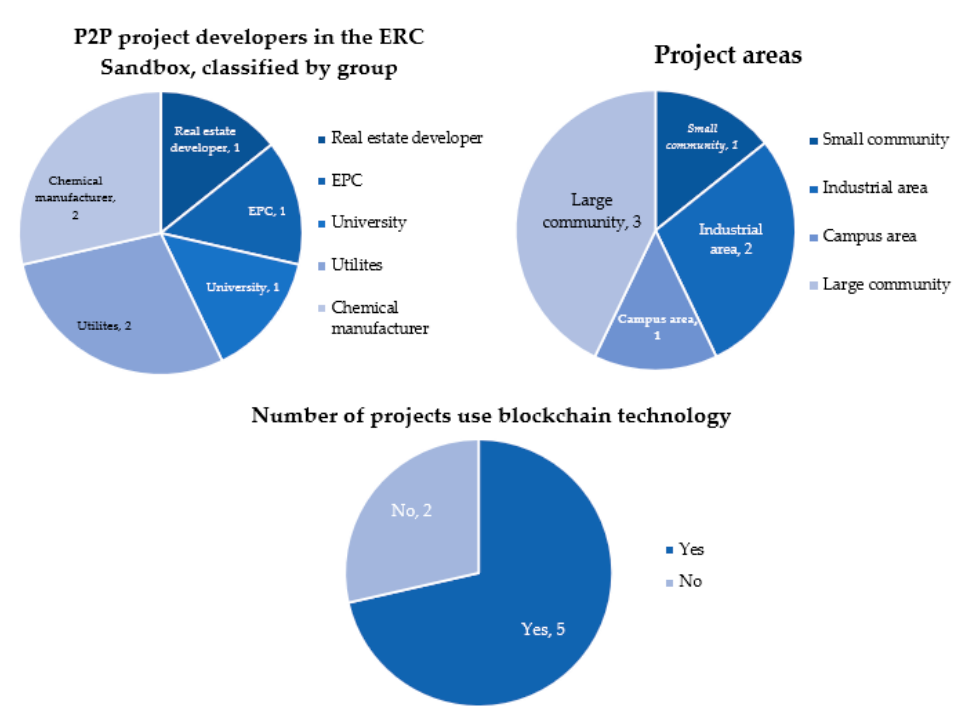
Figure 1. Overview of P2P projects in the ERC sandbox program in Thailand classified by project developer, project area, and the use of BT.